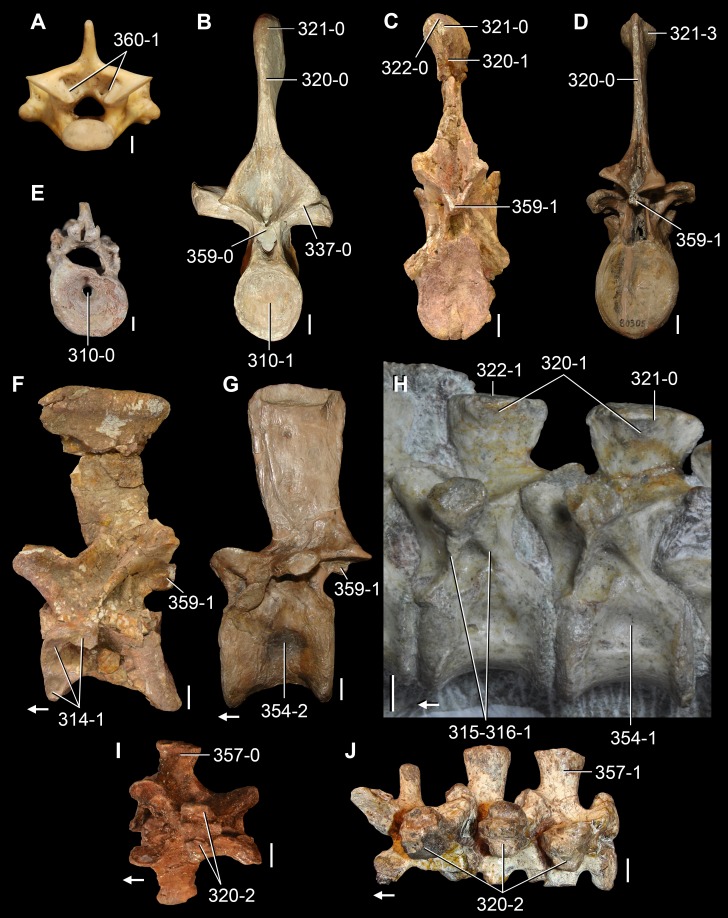
Presacral vertebrae of Permo-Triassic and Recent saurians in (A–E) posterior, (F–H) lateral, and (I, J) dorsal views.(A) Salvator merianae (MACN-He 47992); (B) Tanystropheus longobardicus (SMNS 55341); (C, F) Guchengosuchus shiguaiensis (IVPP V8808-10); (D, G) Batrachotomus kupferzellensis (SMNS 80296, [G] mirrored); (E) Aenigmastropheus parringtoni (UMZC T836); (H) Euparkeria capensis (SAM-PK-6047A); (I) Prolacerta broomi (BP/1/2675); and (J) Proterosuchus fergusi (GHG 363). Numbers indicate character-states scored in the data matrix and the arrows indicate anterior direction. Scale bars equal 2 mm in (A, G, H), and 1 cm in (B–F, I).